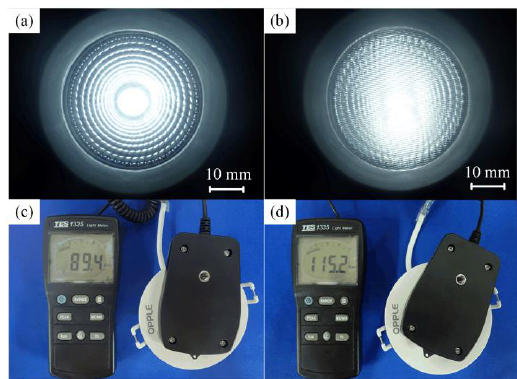
Figure 7. The light efficiency testing photos of the LED diffusion plates: ( a ) traditional diffusion plate; ( b ) micro-structured diffusion plate; ( c ) Light intensity of traditional diffusion plate; ( d ) Light ff usion plate; ( c ) Light intensity of traditional di ff usion plate; ( d ) Light intensity intensity of micro-structured diffusion plate. ( b ) micro-structured di of micro-structured di ff usion